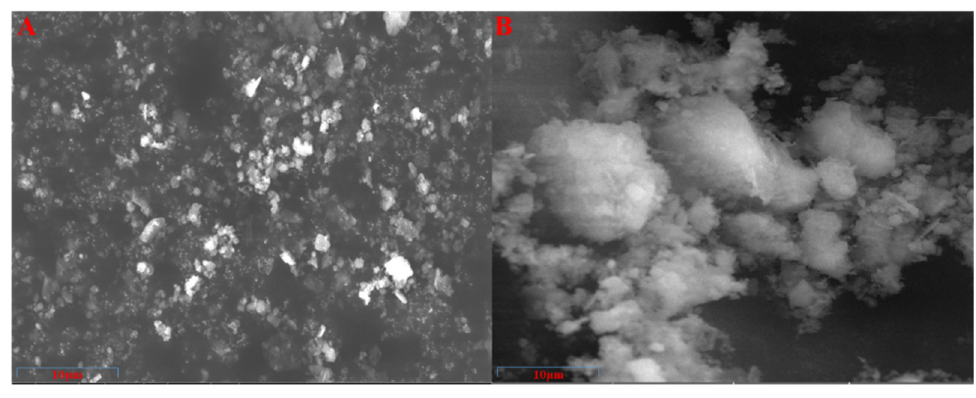
Figure 18. SEM analysis of red mud. ( A ) red mud before dealkalization, ( B ) red mud after dealka-